Question: State the chart type depicted above.
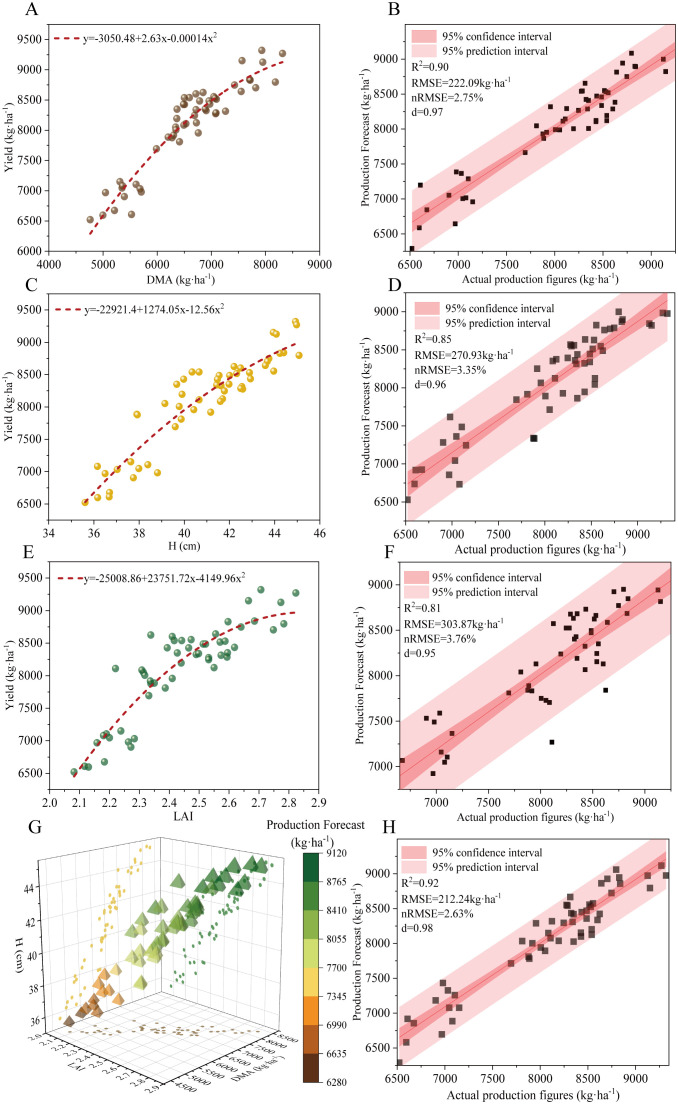
Answer: line